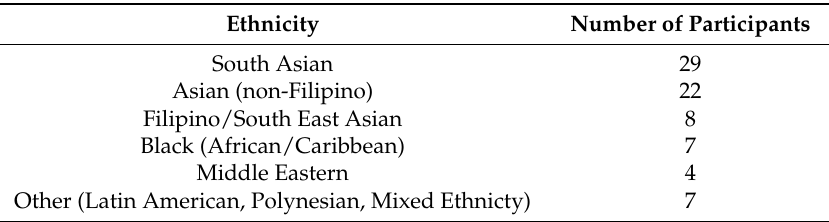
Table 2. Ethnic Breakdown of Study Participants.